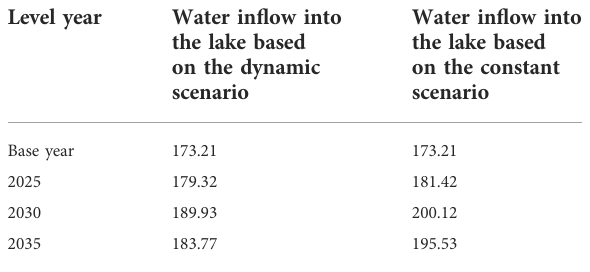
TABLE 6 In fl ow of water from the Jing River to Ebinur Lake under different boundary conditions of the recommended scheme (unit: 10 6 m 3